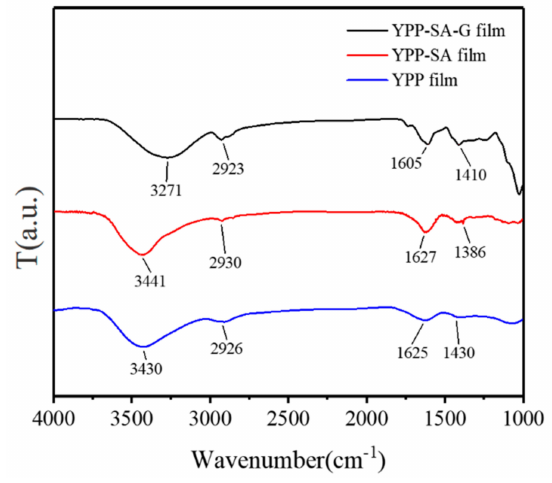
Figure 3. FTIR curves of various films (YPP, YPP–SA, YPP–SA–G).